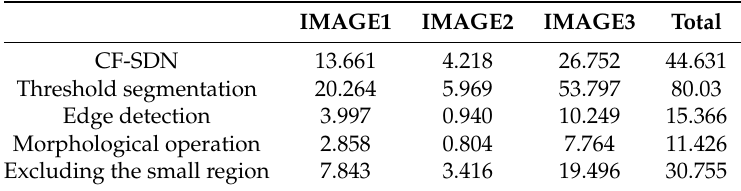
Table 6. Time spent at different phases during the test(unit: second).